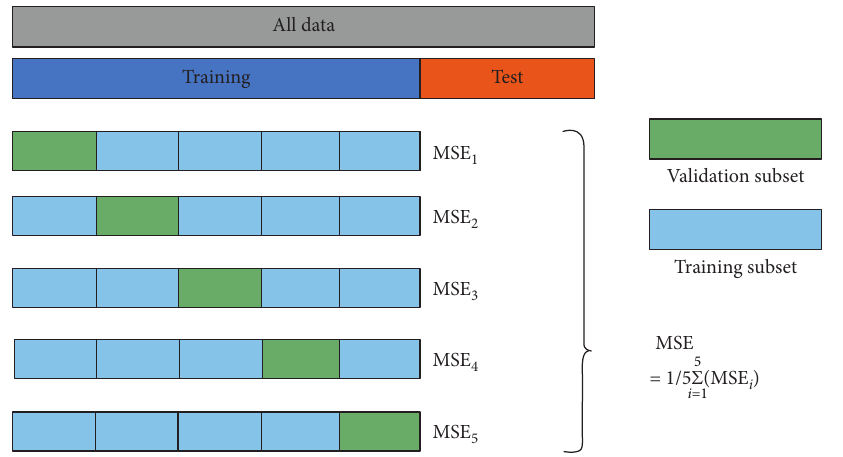
Figure 5: Schematic of 5-fold